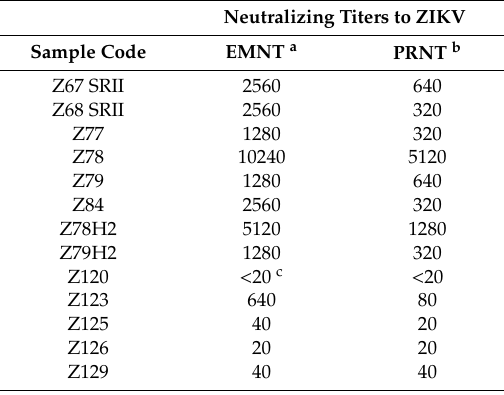
Table 3. Neutralizing Titers of 13 ZIKV IgG Positive Clinical Samples to ZIKV by Using BHK-21 Cells.